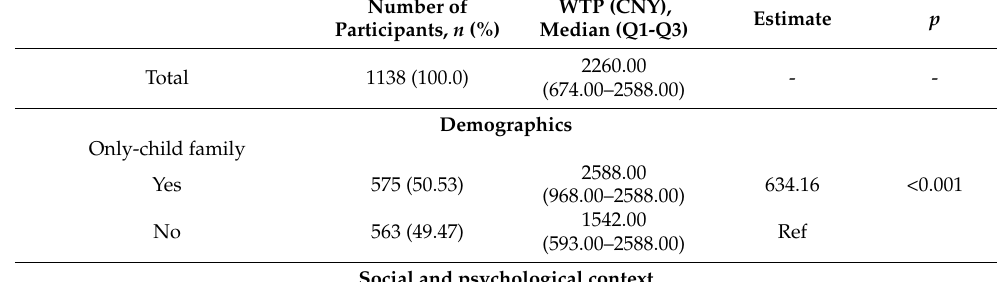
Table 3. Drivers for caregivers’ willingness to pay (WTP) to vaccinate children with 13 -valent pneu- mococcal conjugate vaccines.